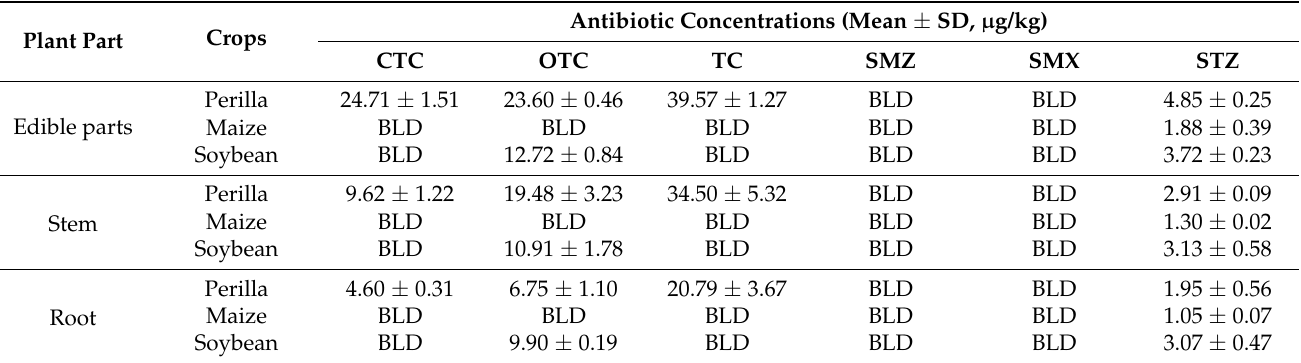
Table 6. Concentrations of antibiotics in the edible parts, stems, and roots of